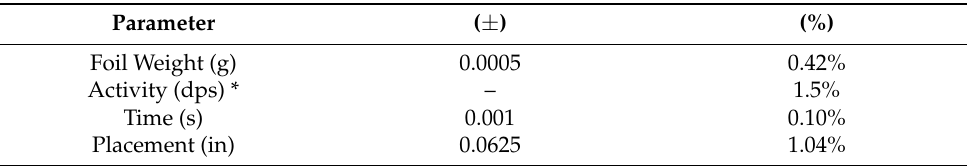
Table 4. Uncertainties in measured parameters used to calculate neutron flux. Parameter ( ± ) Foil Weight